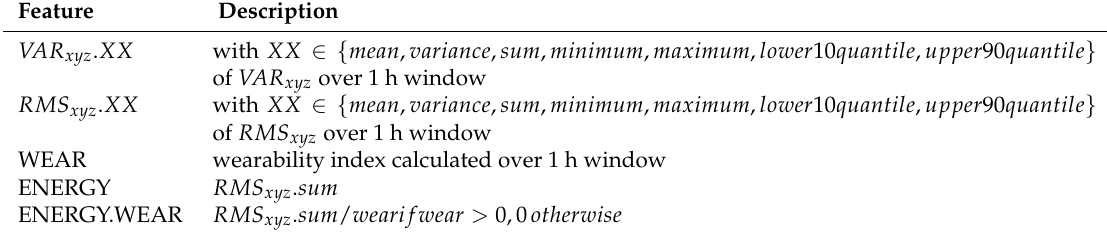
Table 3. Statistical features extracted from the Euclidean norm of the three-axis acceleration signal: these features are used for a